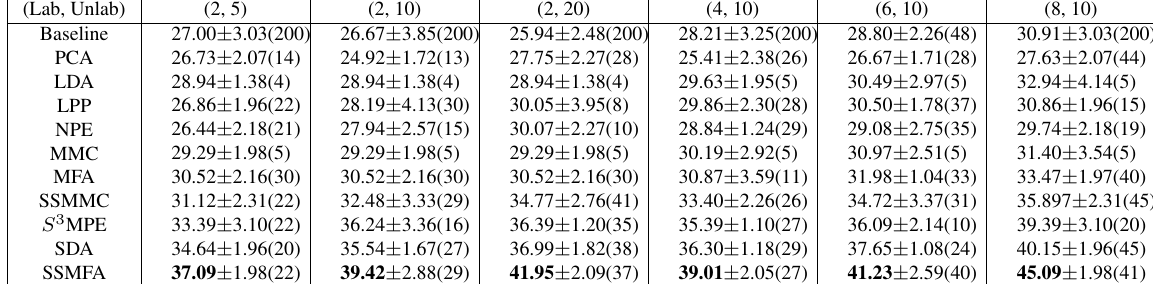
Table 3: Comparison of different methods for AVIRIS Indian Pines data set ( mean + std ( dim